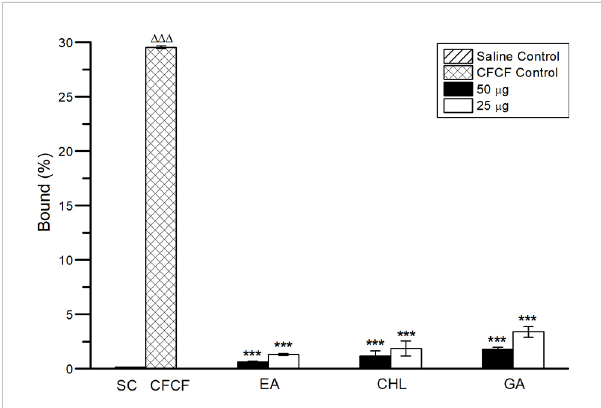
FIGURE 13 Cellular cAMP levels in ligated-ileal tissues. All values were expressed as mean ± SD, One Way Analysis of Variance (ANOVA) followed by the Dunnett test. DDD p <0.001, compared with Saline control. *** p < 0.001 compared with CFCF